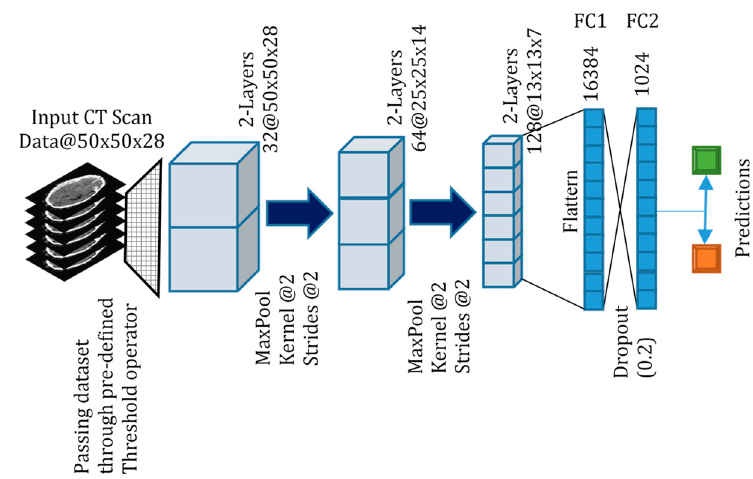
Figure 2. Proposed architecture for binary and multi-class classification of CT scans. The features are visualized using 3D deconvolution visualization methods at each pooling layer. Table 2. Model architecture of the 3-dimensional convolutional neural networks (3D CNN) used in this work.